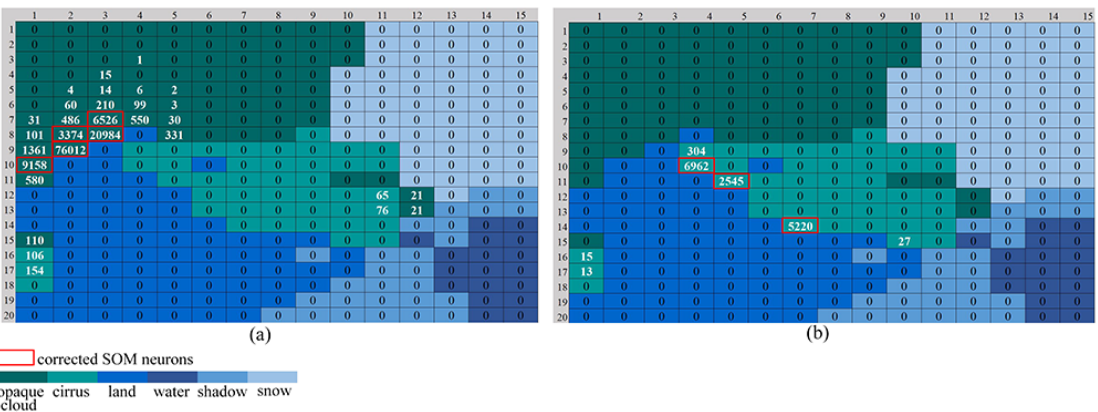
Figure 4. Number of hits for the sampled non-cloud spectra. ( a ) Image with high number of activated neurons, ( b ) image with low number of activated